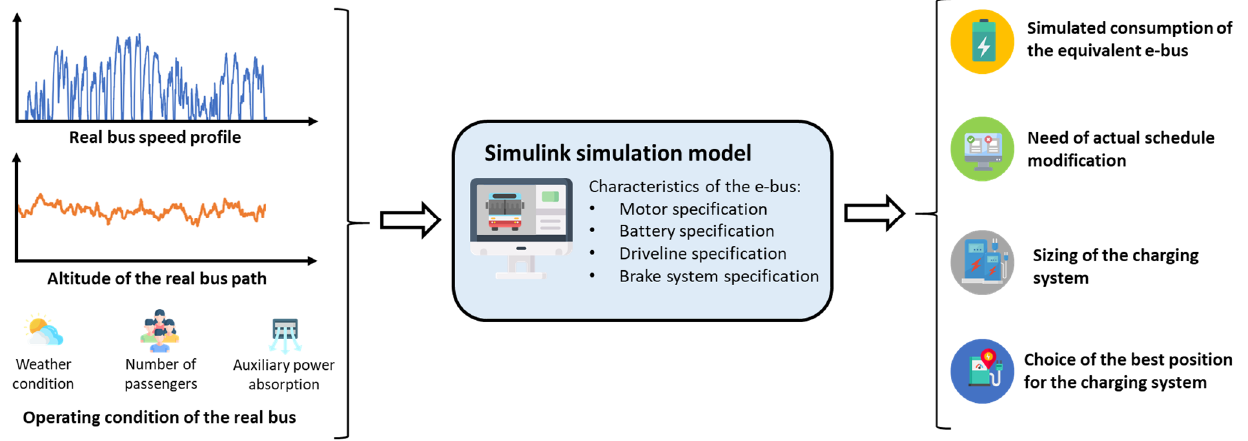
Figure 2. Graphic representation of the implemented